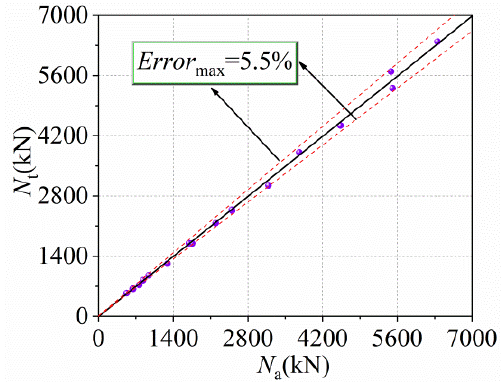
Figure 4. Compression between N